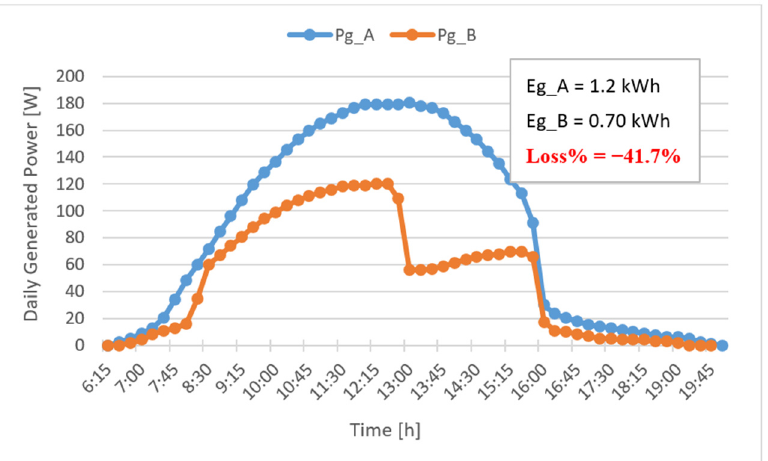
Figure 8. Daily power generation curves, Pg_A and Pg_B, of the two prototypal PV generators A and B on a July 2021 cloudless day, together with corresponding daily generated energy values, Eg_A and Eg_B, and the percentage energy loss factor, Loss%. In this experiment, a shading plywood sheet was mounted only on three PV cells of the homemade submodule of the PV generator B, and the corresponding bypass diode intervened early but left the conduction mode at about 13:00.